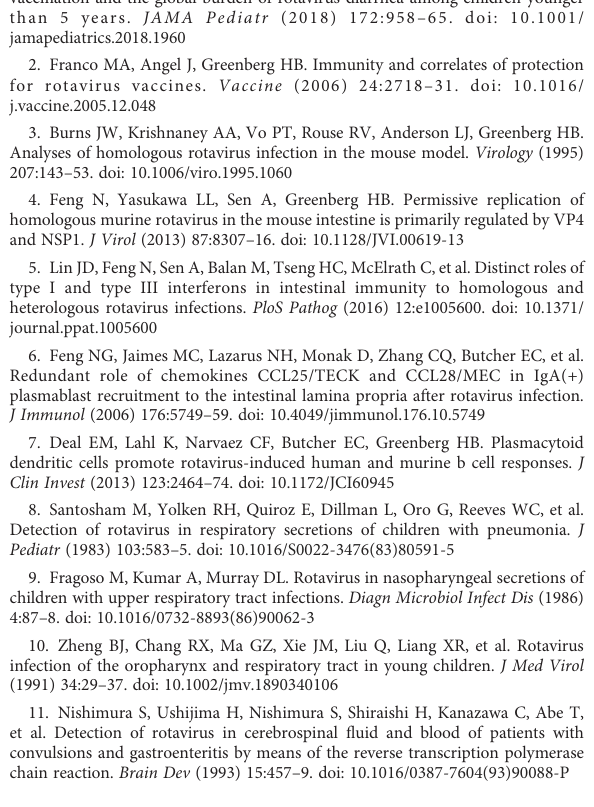
SUPPLEMENTARY FIGURE 1 The NSP3 sequences from cell culture passaged viruses. The sequences of NSP3 of parental virus, P4 and P8 from serial passages subjected to RT- PCR and Sanger sequencing. The NSP3, P2A, and NLuc junctions were shown.